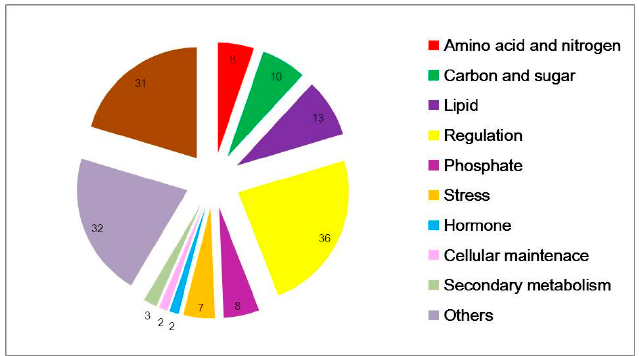
Figure 2. Functional categorization of differential expressed genes in common between two microarray datasets. The probe set sequences were mapped to the UniRef protein database and then subsequently to KEGG function categories, as described in the text. KEGG: Kyoto Encyclopedia of Genes and Genomes.